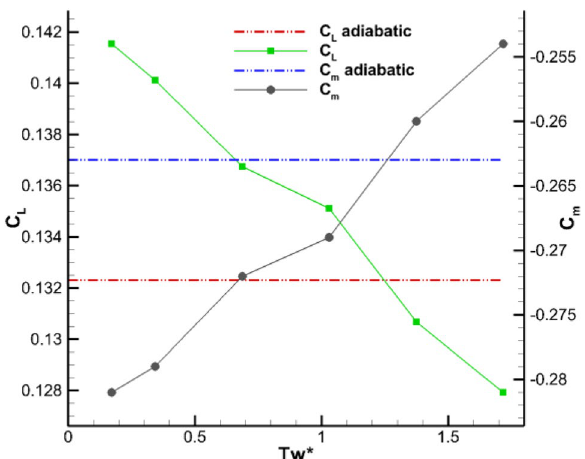
Figure 9. Influence of wall temperature gradient on model lift and pitching moment coefficients ( M = 0.9, α =